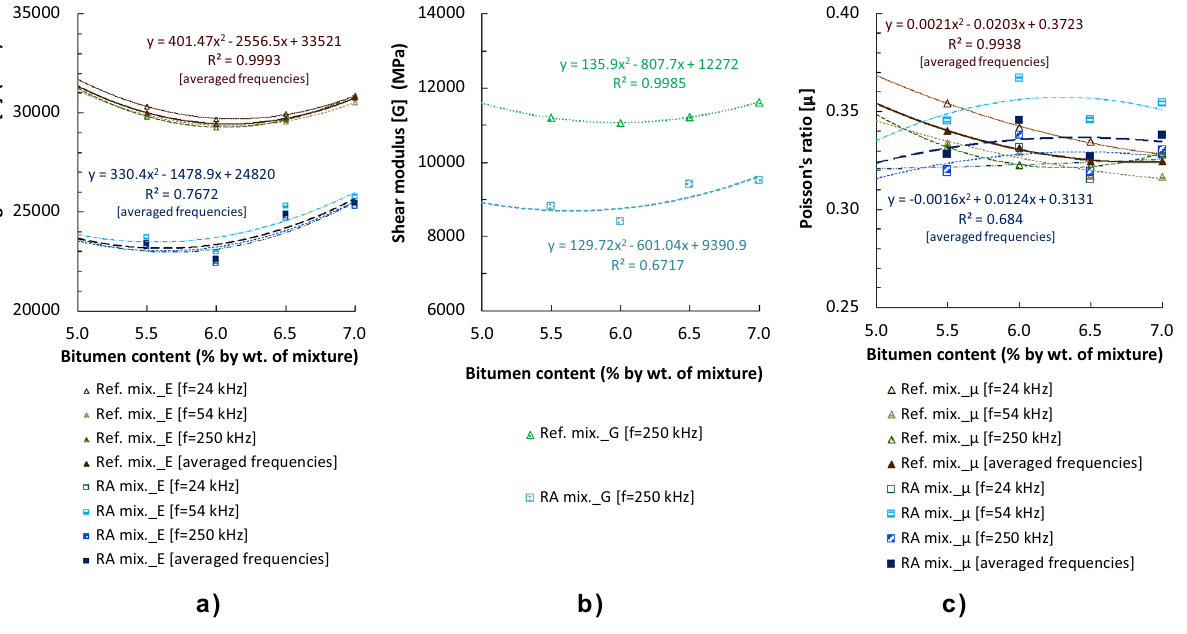
Figure 8. Elastic constants obtained by ultrasounds on cylindrical specimens (compacted by impact with 2 × 75 blows), at 20 °C and different pulse frequencies: ( a ) Young’s modulus (E); ( b ) Shear modulus (G); ( c ) Poisson’s ratio